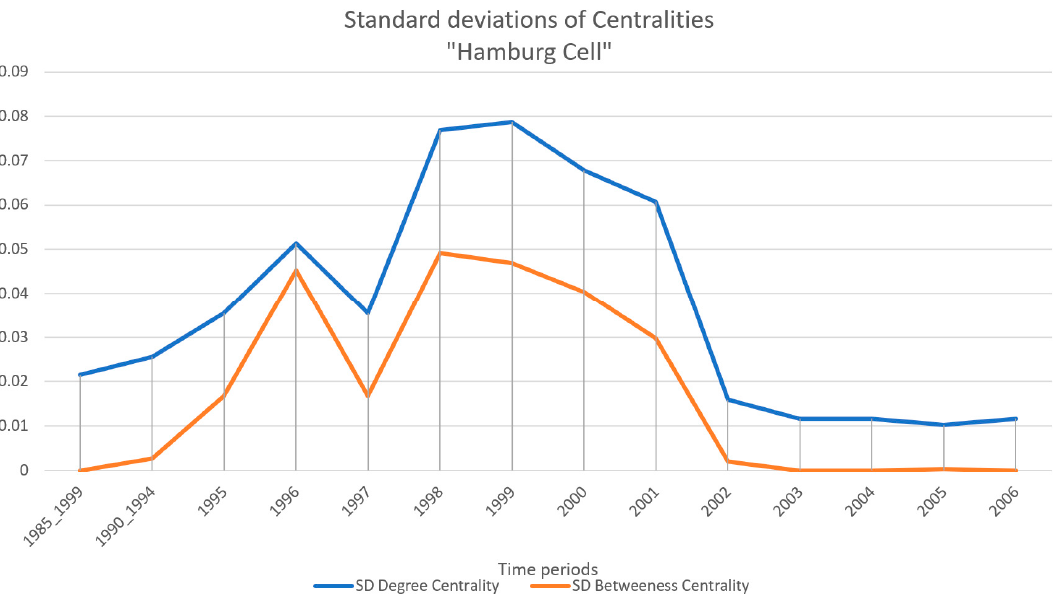
Figure 18. Temporal development of the standard deviation of degree centrality and the standard deviation of betweenness centrality for the “Hamburg Cell”. Both indices fluctuate, with two maximum values in 1996 and 1998. Both indices decrease rapidly after 2001.